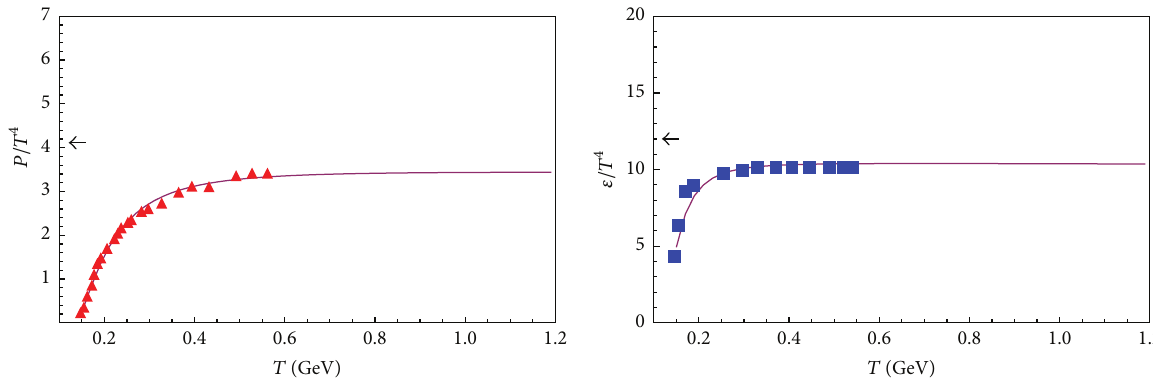
Figure 2: The symbols show the MC LR for the pressure and the energy density in case of 𝑛 𝑓 = 2 QCD equation of state [36]; the line corresponds to the equation of state (35) for the pressure in the left panel and (36) for the energy density in the right panel with 𝜎 = 10.403 , 𝐵 = −4.9𝑇 4 𝑃/𝜀 = 1/3 (i.e., the SB 𝐴 = −8.72895𝑇 3 𝑐 , and 𝑐 . The arrows in the above figures correspond to